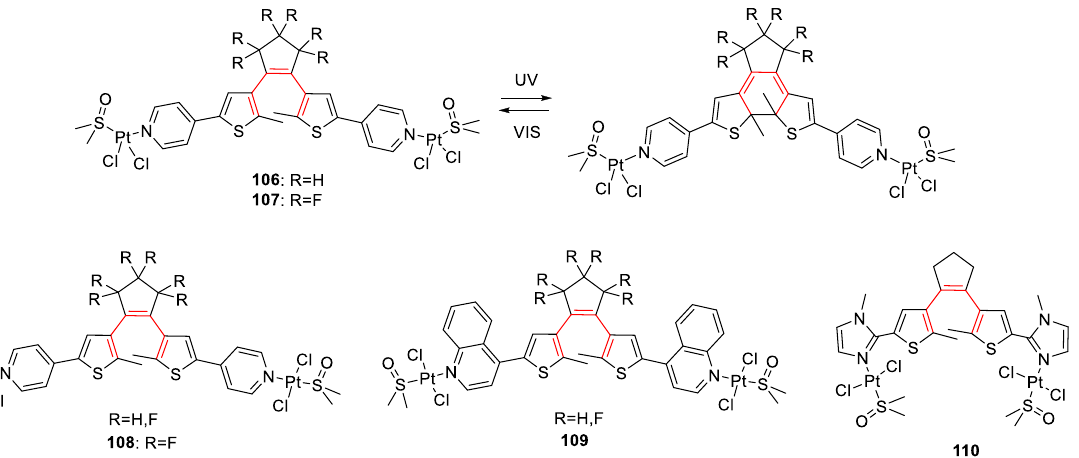
Figure 18. Photoswitchable metal complexes, the photoswitch unit indicated in